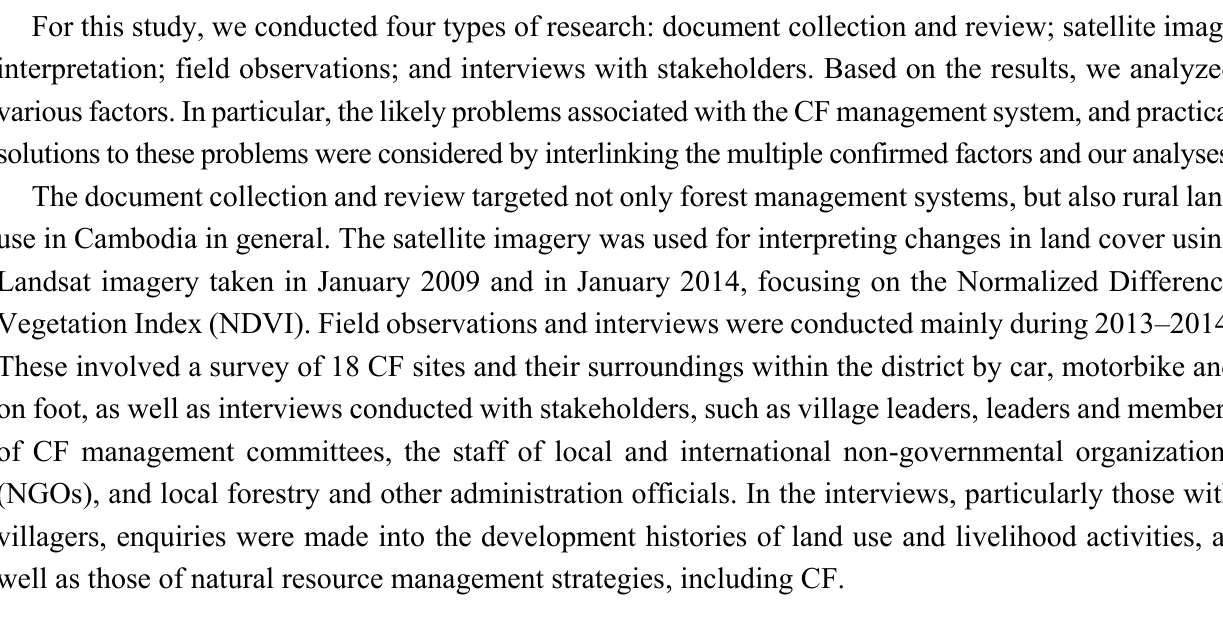
Figure 1. Location of Kampong Thom (KT) Province and Sandan (SD) District in